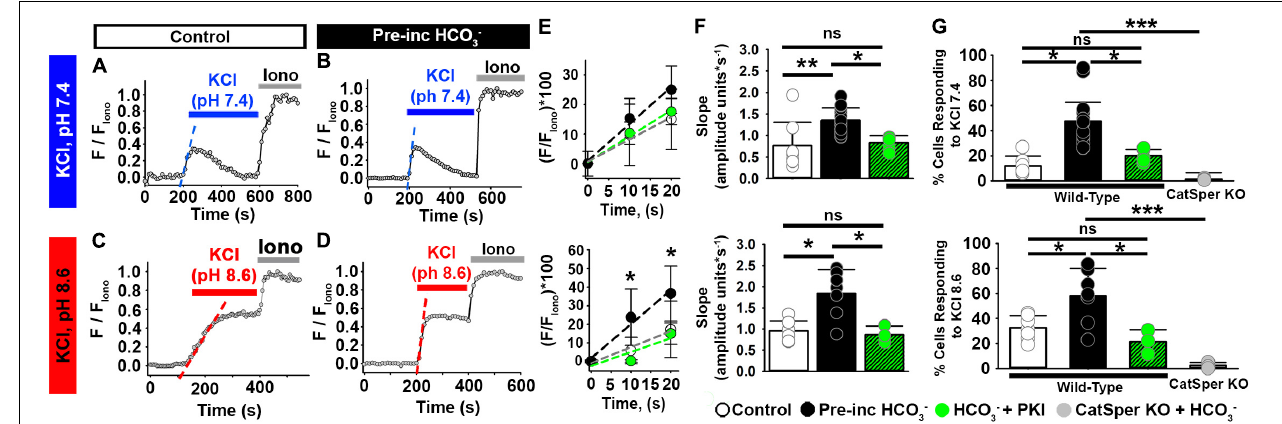
FIGURE 3 | HCO 3 − enhances the depolarization-evoked responses from mouse epididymal NC sperm and its effect is inhibited by the PKA inhibitor PKI. (A–D) Representative traces of [Ca 2 + ] i responses to 50 mM KCl at (A,B) pH 7.4 and (C,D) pH 8.6 in mouse epididymal sperm in non-capacitating conditions. (E) Linear fit of the averaged normalized fluorescence in the first 20 s after KCl addition [blue or red dashed lines in panels (A–D) ] in responding sperm. (F) Graph of the slope values of the best-fit regression line for each condition. Mean values at pH 7.4 were as follows: control, 0.76 ± 0.547 amplitude units * s − 1 (8 mice, 307 sperm); HCO 3 − , 1.35 ± 0.297 amplitude units *s − 1 (15 mice, 1035 sperm); and HCO 3 − + PKI, 0.83 ± 0.166 amplitude units *s − 1 (5 mice, 264 sperm). Mean values at pH 8.6 were as follows: control, 0.95 ± 0.237 amplitude units * s − 1 (7 mice, 243 sperm); HCO 3 − , 1.84 ± 0.556 amplitude units *s − 1 (7 mice, 281 sperm); and HCO 3 − + PKI, 0.86 ± 0.203 amplitude units *s − 1 (3 mice, 126 sperm). (G) Graph of the percentage of responsive sperm. Mean values at pH 7.4 were as follows: control, 11.80% ± 6.9 (8 mice, 307 sperm); HCO 3 − , 47.6% ± 19.39 (15 mice, 1035 sperm); HCO 3 − + PKI, 20.1% ± 5.30 (5 mice, 264 sperm); and HCO 3 − in CatSper KO mice, 1.37% ± 0.623 (5 mice, 137 sperm). Mean values at pH 8.6 were as follows: control, 32.6% ± 9.58 (7 mice, 243 sperm); HCO 3 − , 58.0% ± 21.940 (7 mice, 281 sperm); HCO 3 − + PKI, 21.45% ± 9.513 (3 mice, 126 sperm); and HCO 3 − in CatSper KO mice, 2.34% ± 2.524 (3 mice, 95 sperm). * P < 0.050, ** P < 0.010, *** P < 0.001, and ns, non-significant by one-way ANOVA. Error bars indicate standard deviation. Iono = 5 µ M Ionomycin + 2 mM Ca 2 +